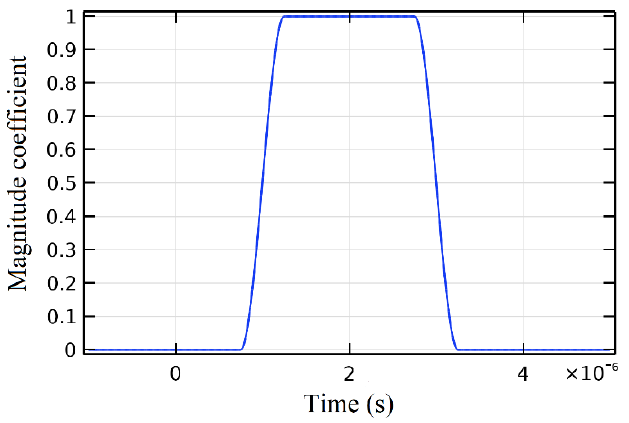
Figure 3. Rectangle function of the increasing pressure in the nozzle.